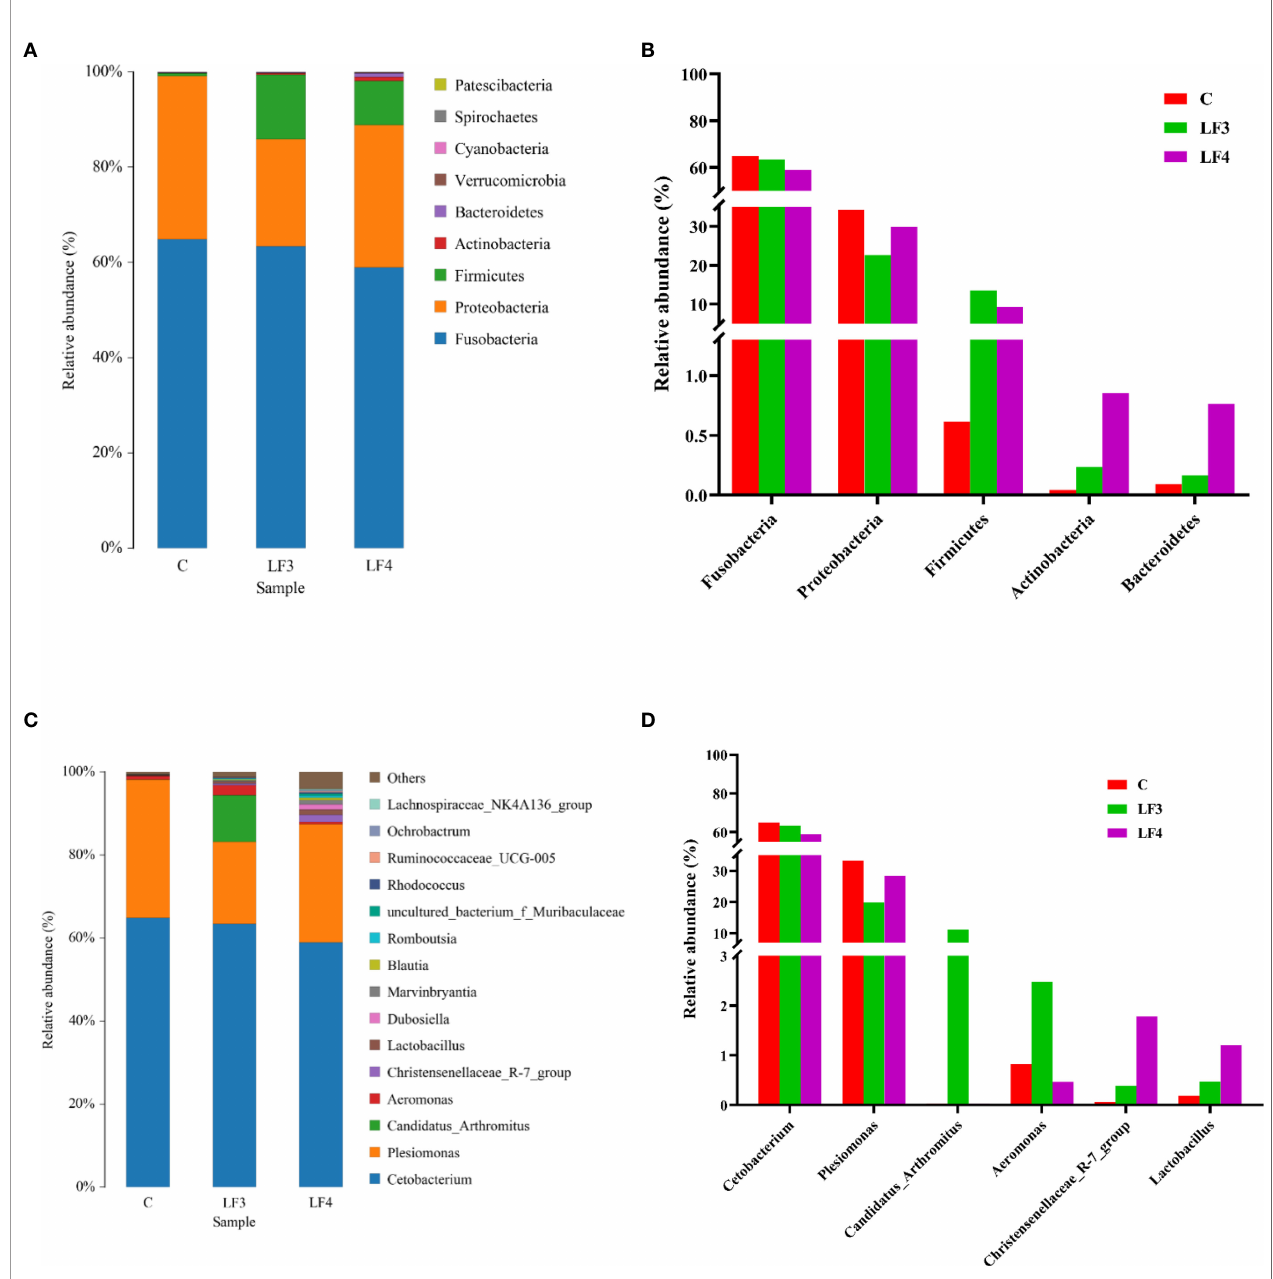
FIGURE 3 | Relative abundances of intestinal microbiota at phyla (A) and genus (C) taxonomic levels in C, LF3 and LF4 groups. The changes of relative abundances of dominant phyla (B) and genus (D)